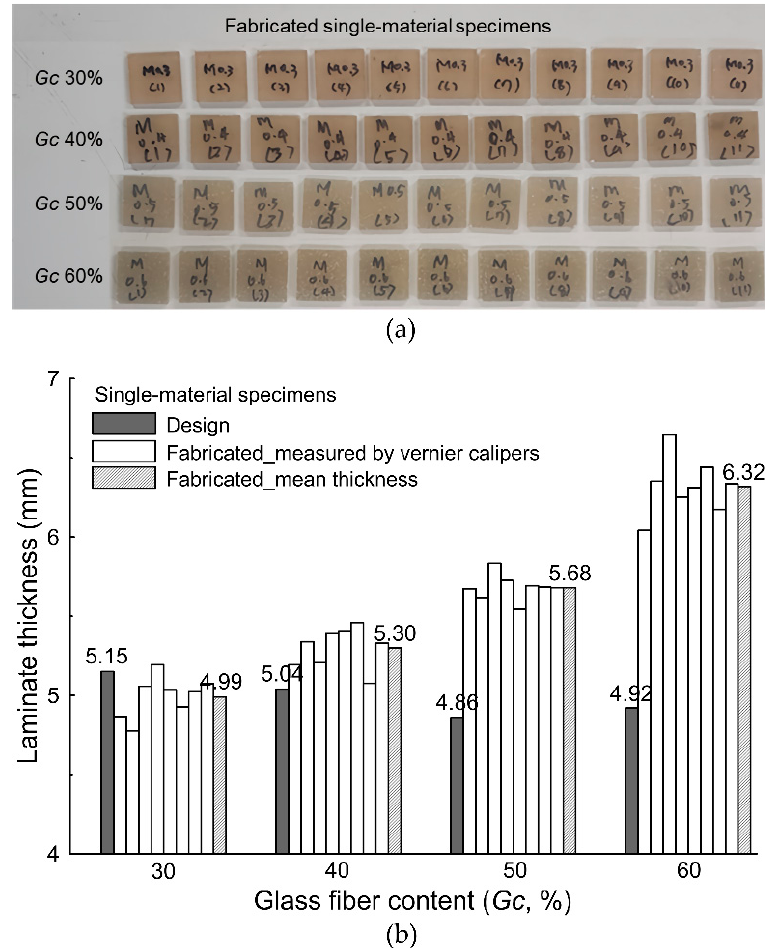
Figure 5. Single-material specimens: ( a ) produced specimens; ( b ) measured thickness.